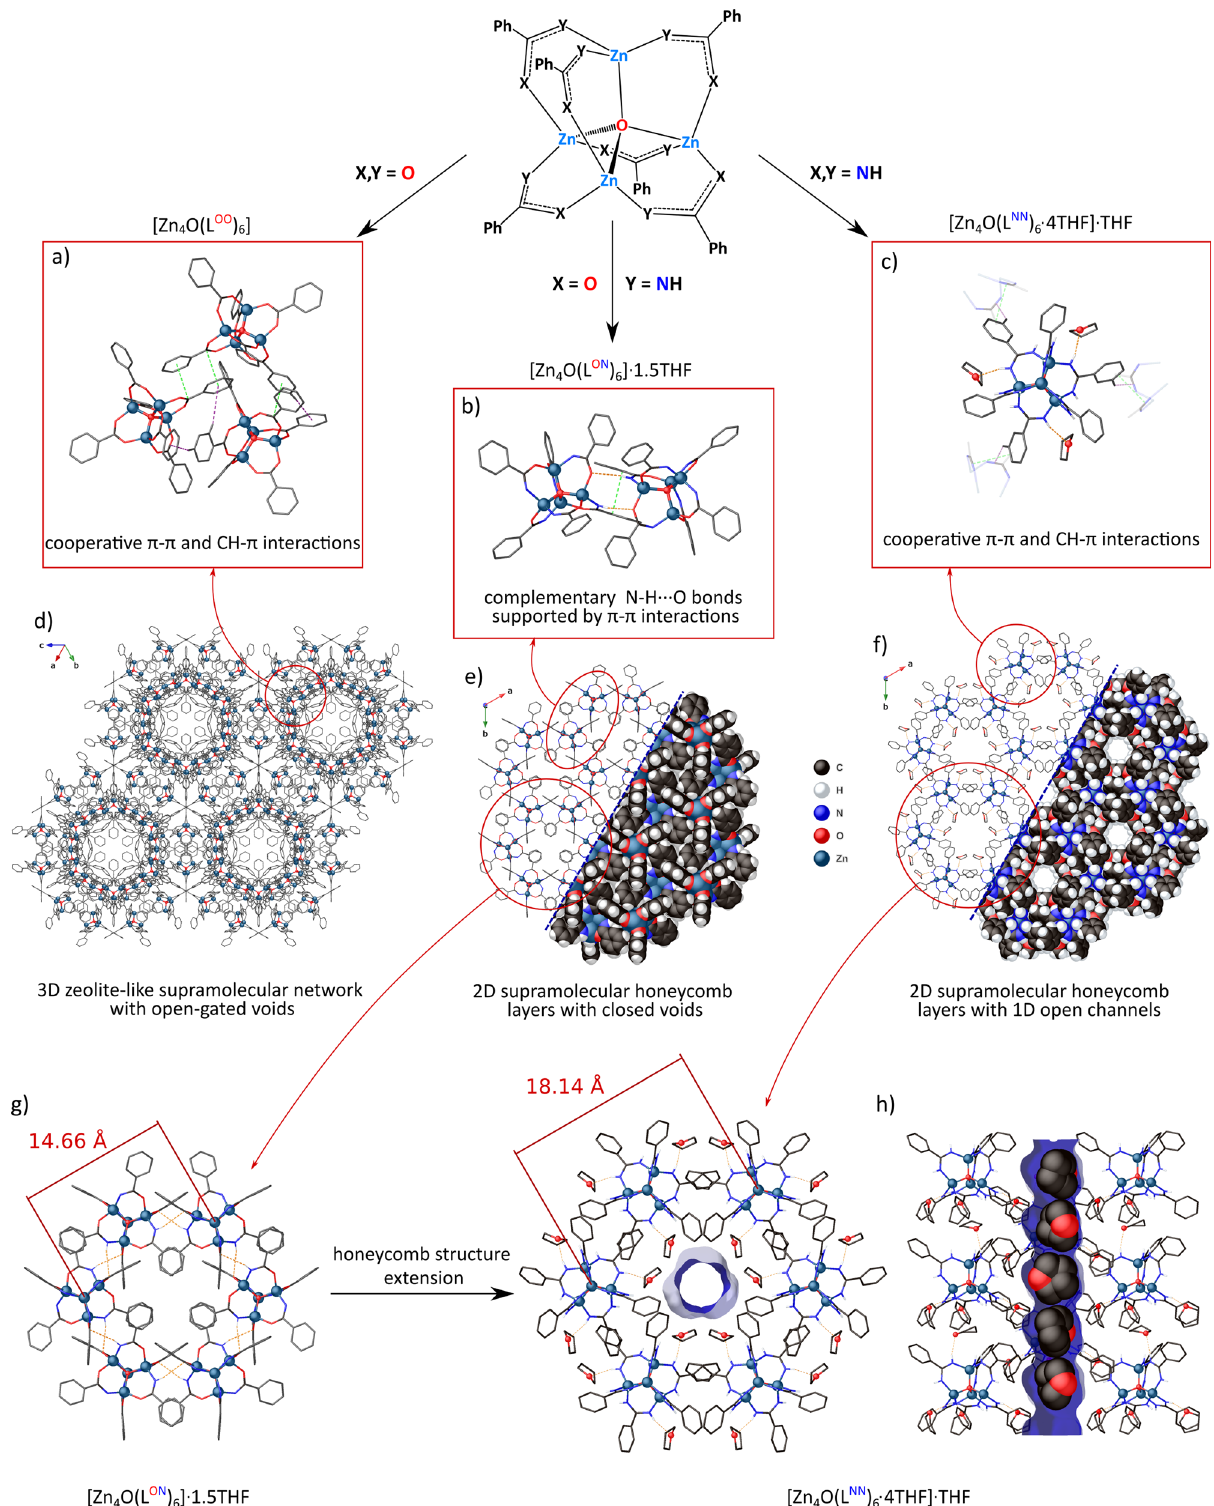
Fig. 3 Self-assembly of the benzoate, benzamidate, and benzamidinate zinc-oxo clusters. Main intermolecular forces governing the self-assembly processes ( a – c ) and supramolecular structures ( d – f ) of [Zn 4 O(L OO ) 6 ], [Zn 4 O(L ON ) 6 ]·1.5THF, and [Zn 4 O(L NN ) 6 ·4THF]·THF. g Representation of the honeycomb structure extension between benzamidate and benzamidinate derivatives. h THF molecules packing in the 1D open channels of [Zn 4 O(L NN ) 6 ·4THF].